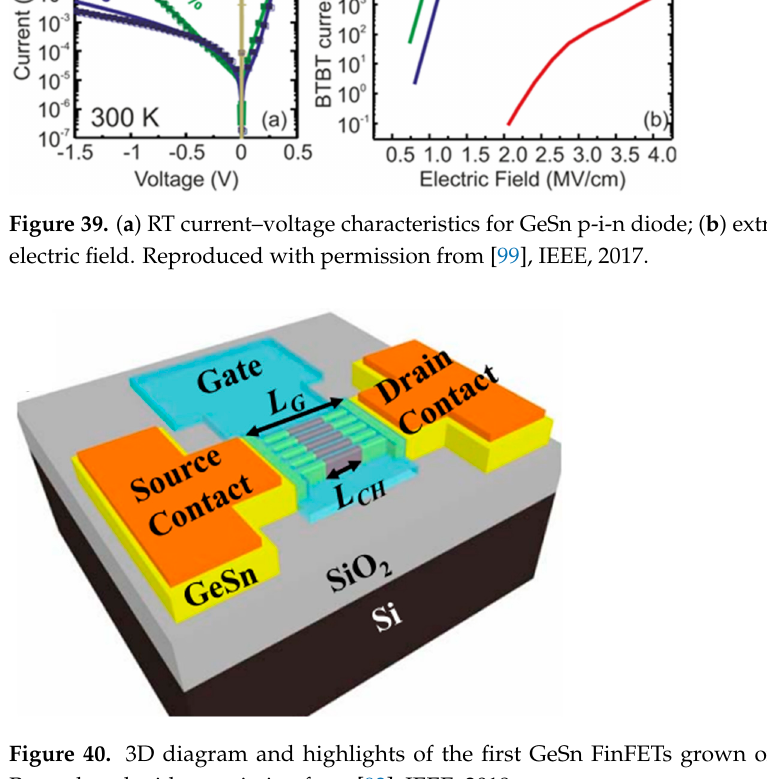
Figure 40. 3D diagram and highlights of the first GeSn FinFETs grown on a GeSnOI substrate. Reproduced with permission from [93], IEEE, 2018.